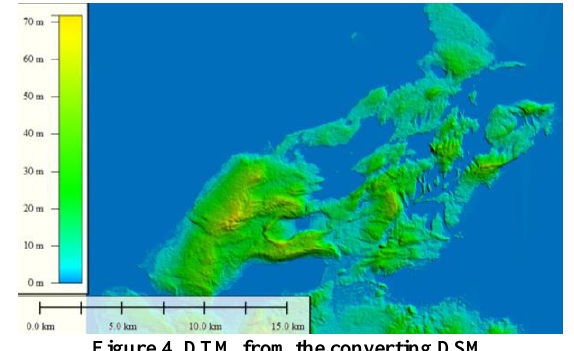
Figure 4. DTM from the converting DSM